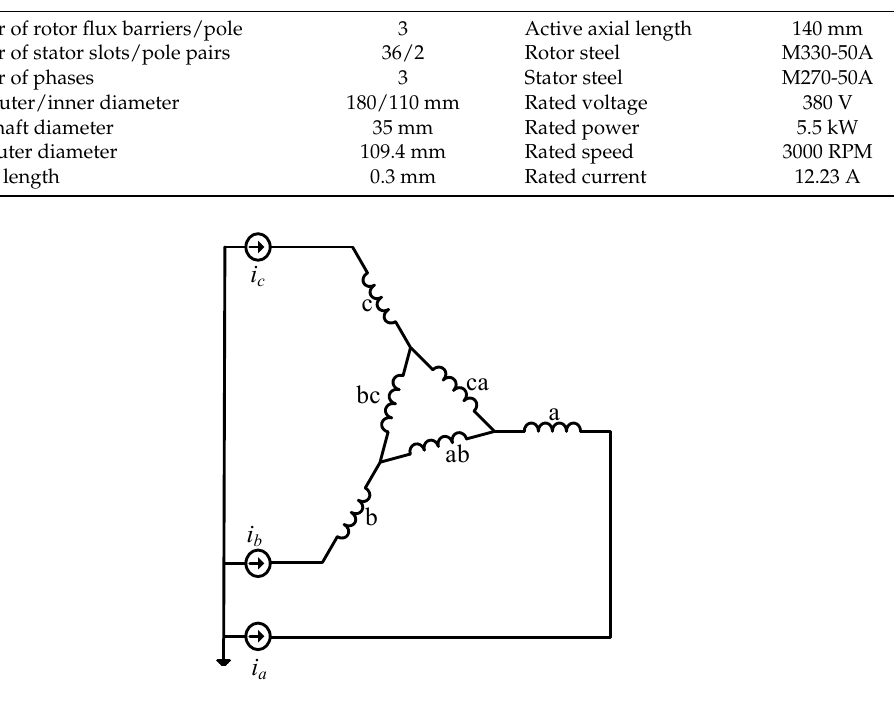
Figure 1. Star–delta coils connected in series.